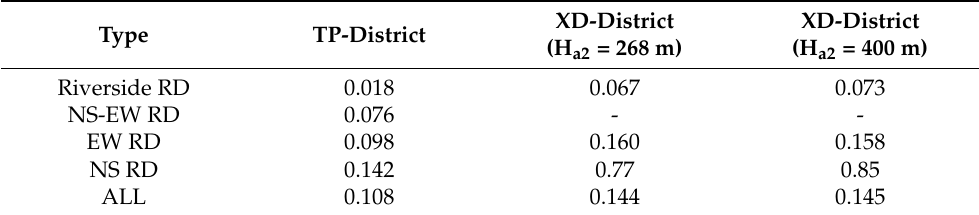
Table 3. Standard deviation of NAIN values for each type of